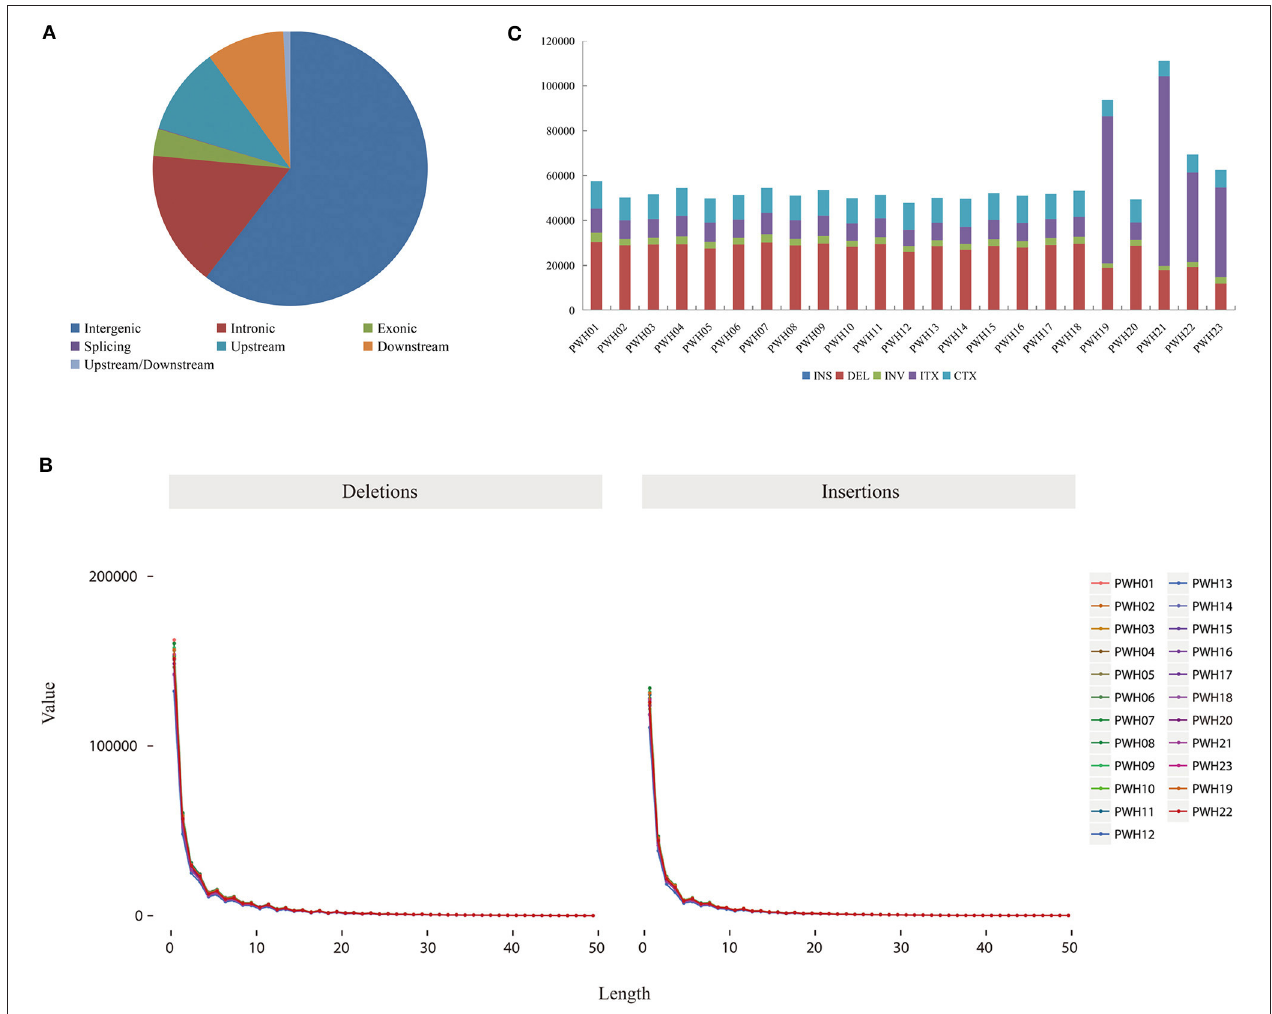
FIGURE 5 | (A) Distribution of SNPs in genomic regions. (B) The distribution of small insertions and deletions in genomic regions per species. (C) The number of different SVs in genomic regions per species.